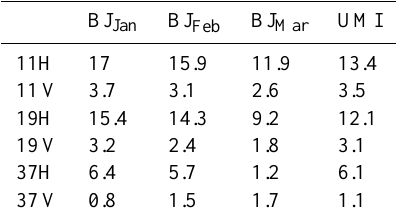
Figure 11. T B sensitivity associated with the ρ IL variation (700– 917kgm − 3 ) . Table 11. T B sensitivity ( (cid:49)T B ρ IL : T B ρ IL917 − T B ρ IL700 ) (K) as- sociated with the ρ IL variation (700–917kgm − 3 )